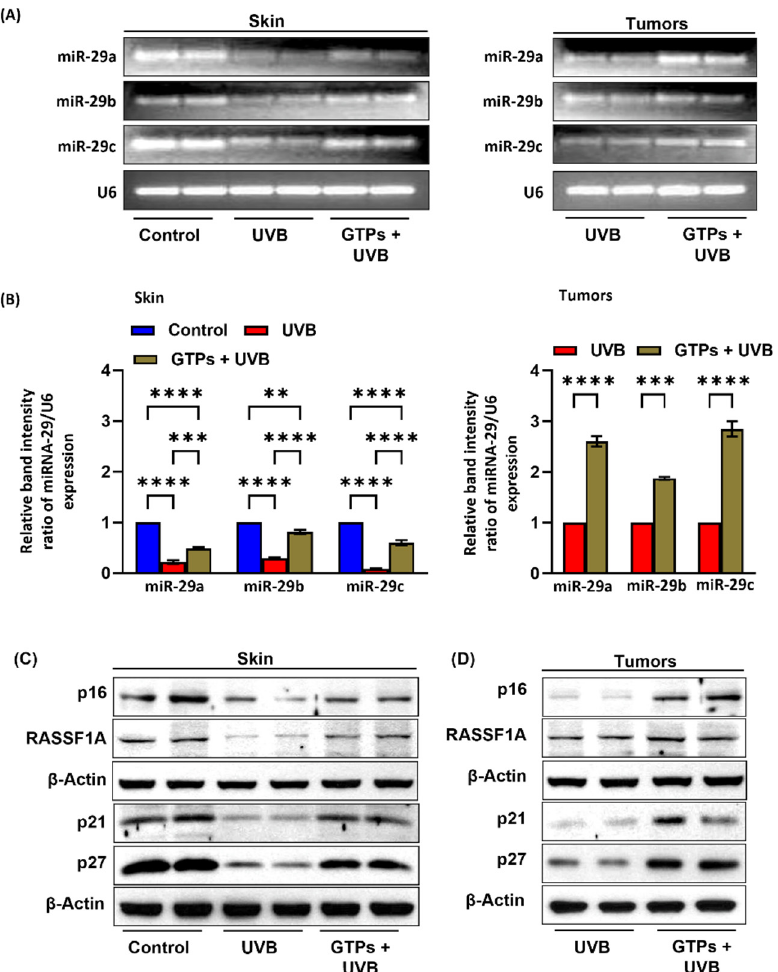
Figure 4. Effect of GTPs on the expression levels of the family members of miR-29 in skin and tumors of SKH-1 hairless mice. Expression levels of miR-29a, 29b, and 29c in skin and tumors ( A ). Relative band intensity of miR-29 expression in skin (left panel) and tumors (right panel), mean values ± S.E.M ( B ). Effect of GTPs on tumor suppressor proteins expression in the skin ( C ) and tumors ( D ) of SKH-1 hairless mice ( n = 6). U6 was used as a loading control. ** p < 0.001 *** p < 0.0005, **** p < 0.0001.